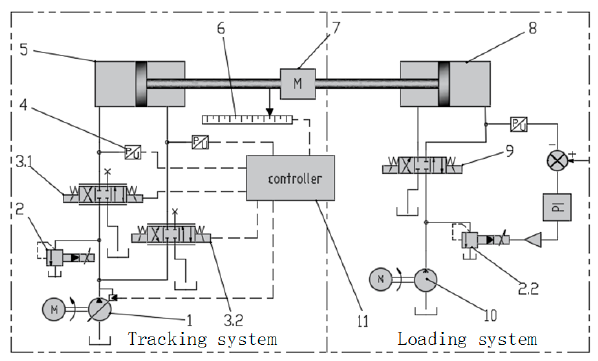
Figure 7. Schematic of the test rig: (1) electro-hydraulic proportional variable pump; (2) relief valve; (3) servo valve; (4) pressure sensor; (5) hydraulic cylinder; (6) position sensor; (7) mass block; (8) loading cylinder; (9) directional valve; (10) hydraulic pump; (11)